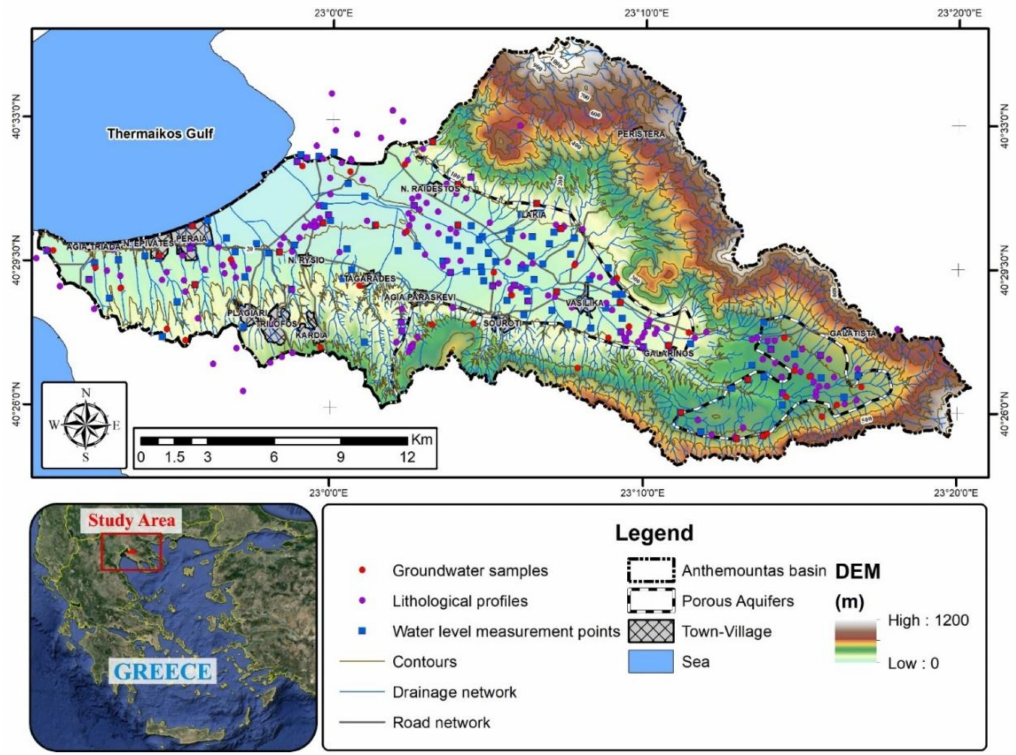
Figure 1. Location and morphological map of the study area of Anthemountas